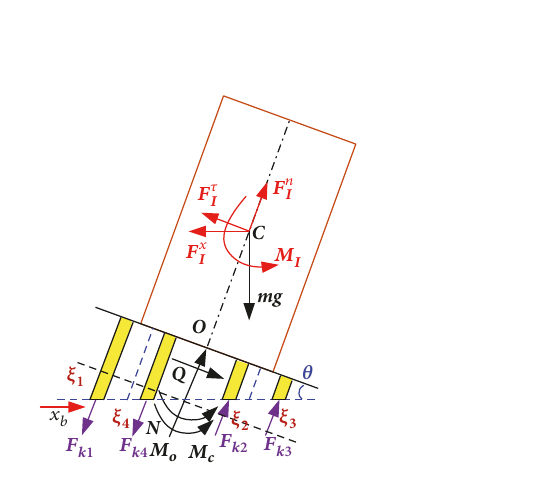
Figure 3: Geometry of ceramic upright pole: (a) side view; (b) top view.